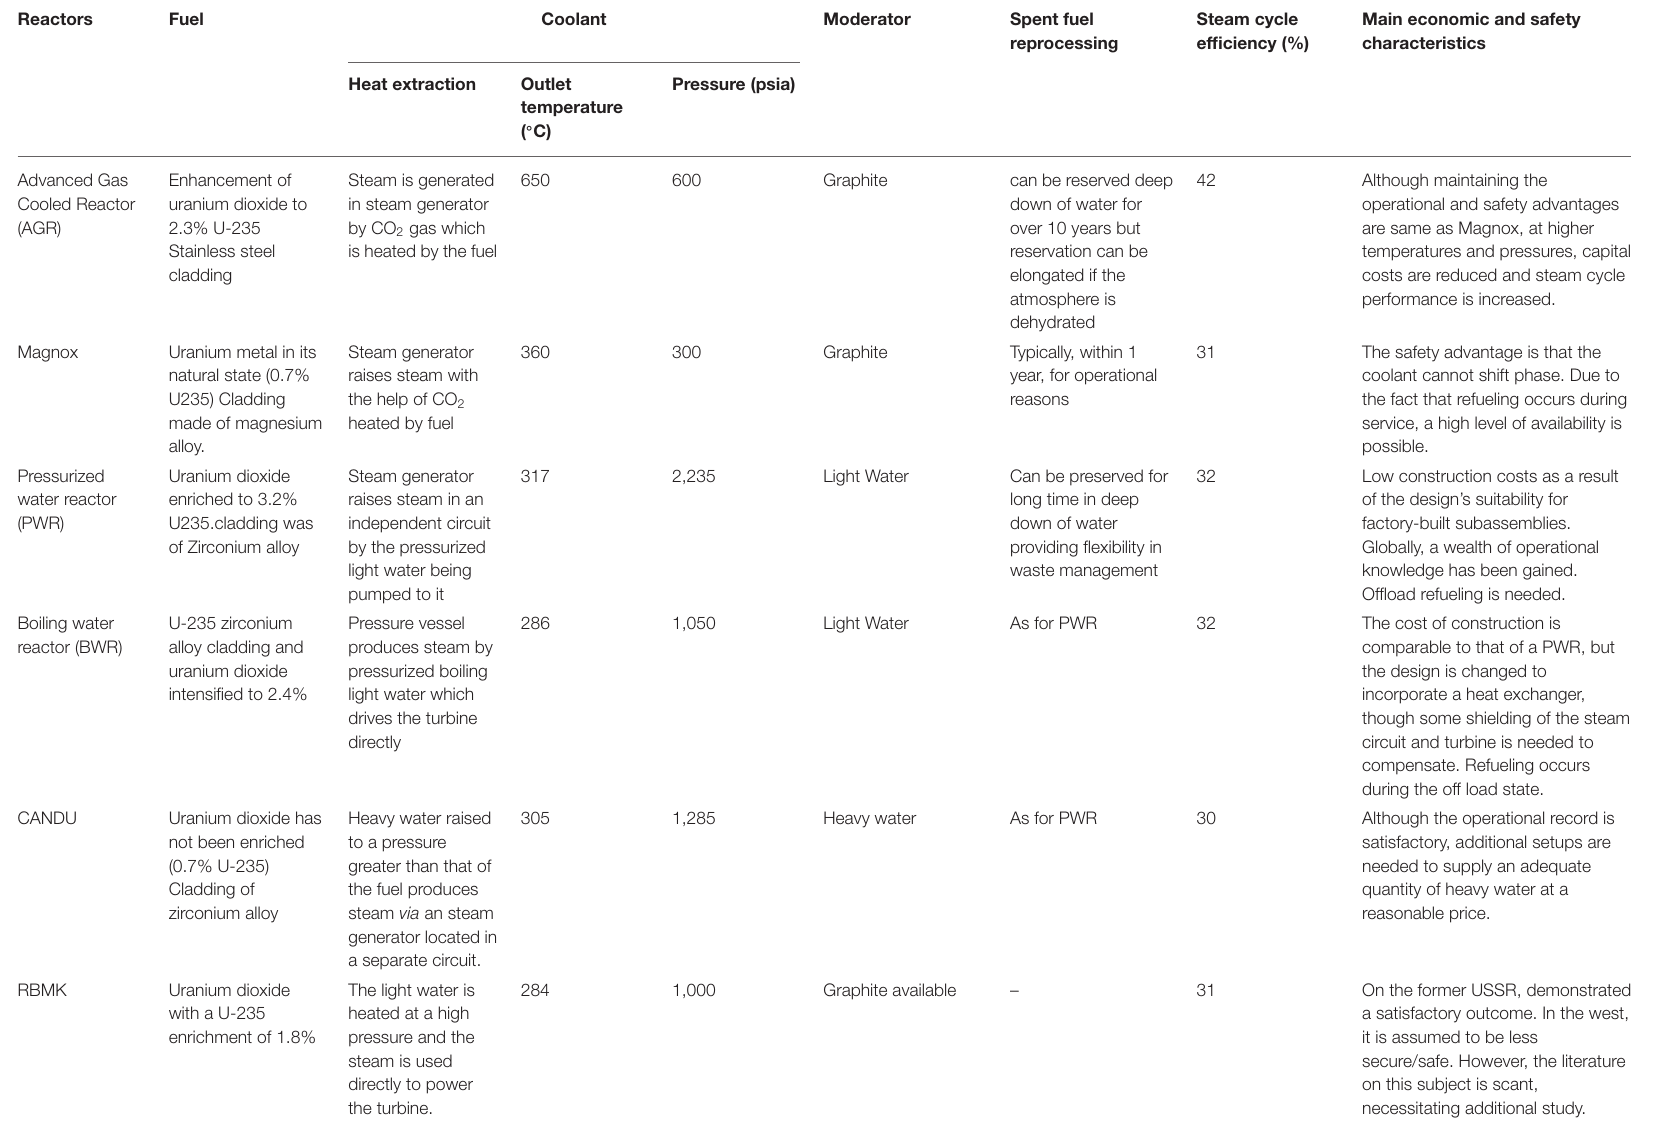
TABLE 2 | Technical details of different types of reactors (Bodansky, 2005; IEE, 2005; Fernández-Arias et al., 2020; U. S. Energy Information Administration, 2020; World Nuclear Association, 2021; Britiannica; Institute for Energy and Environmental Research).